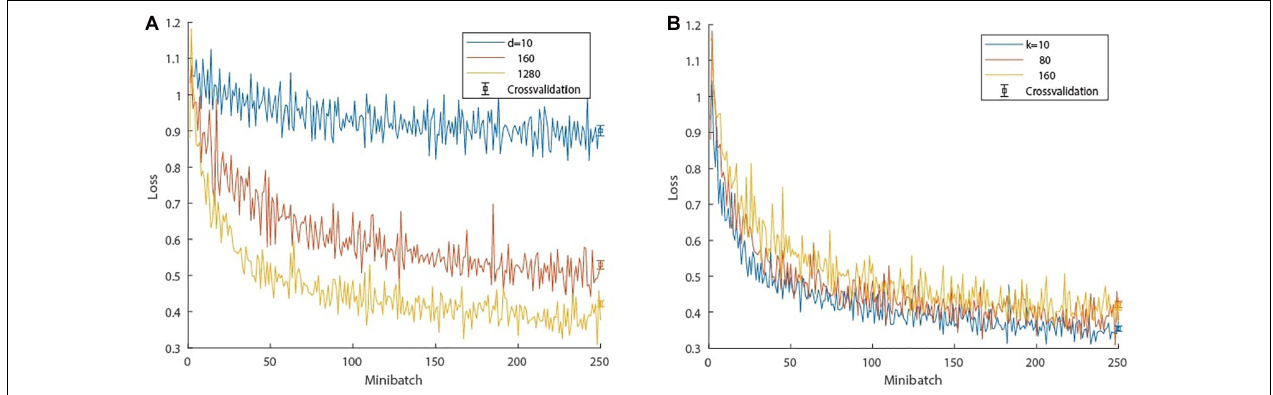
FIGURE 4 | Cross-validation of hyperparameter evaluation. (A) Loss progression: influence of the number of hidden units d in the LSTM network on the performance with a constant look back of k = 80 samples. (B) Loss progression: influence of the look back, i.e., number of past samples k used in the LSTM network with a fixed number of hidden units d = 1280. The bar plots depict the cross-validation testing loss after training. The whiskers denote one standard error and the center refers to the mean loss.